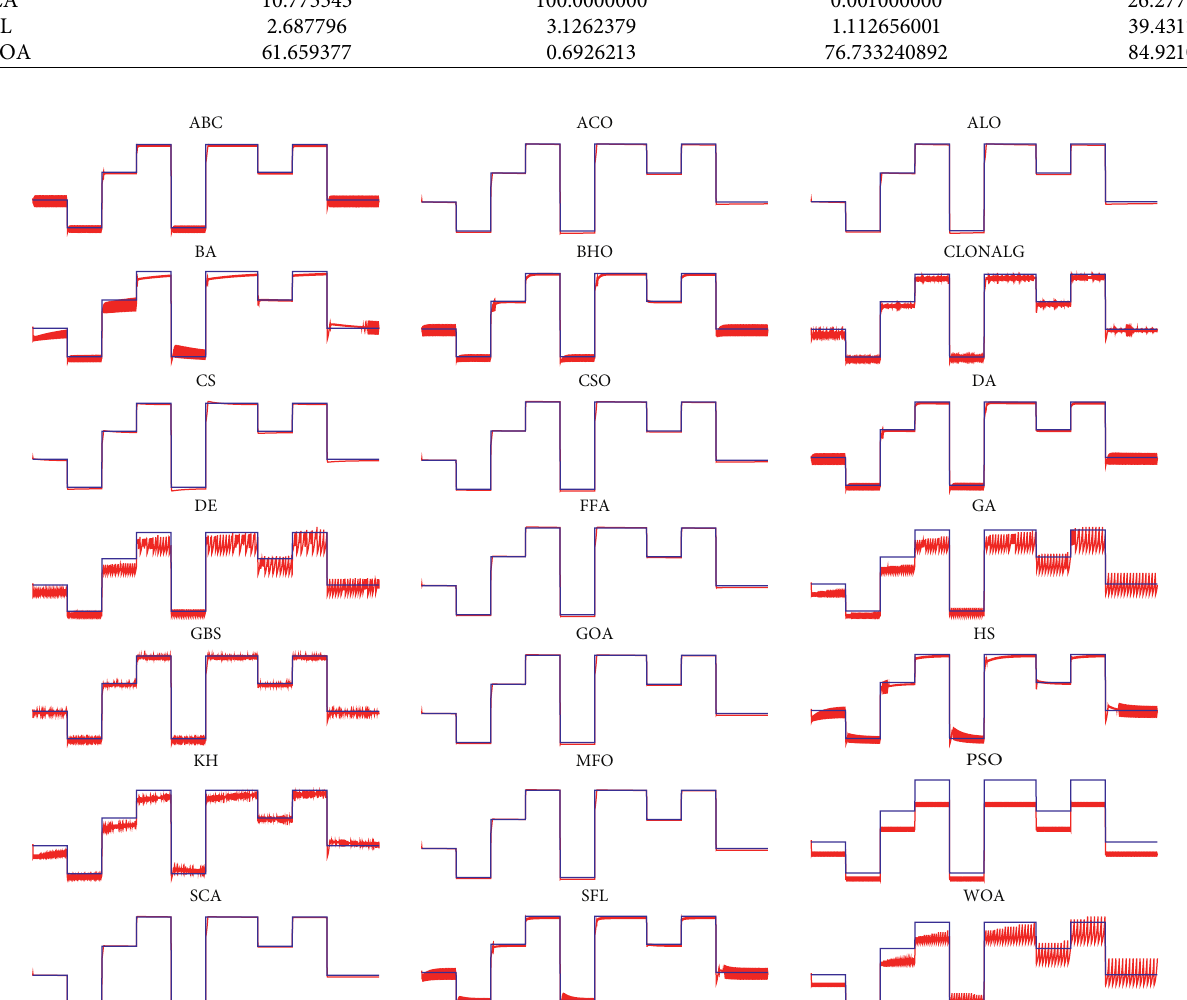
Figure 7: Results of 21 optimization models using a fitness/objective function f components: the red line is target/output signal and the blue line is desired signal, see equation (3) and Table 7. Parameters have been set to the same values for all algorithms, 100 iterations, and a population size of 15 individuals with ( K p ,K i ,K d ) ∈ [ 0 . 001 , 100 ] , in order to get a similar testing environment for all